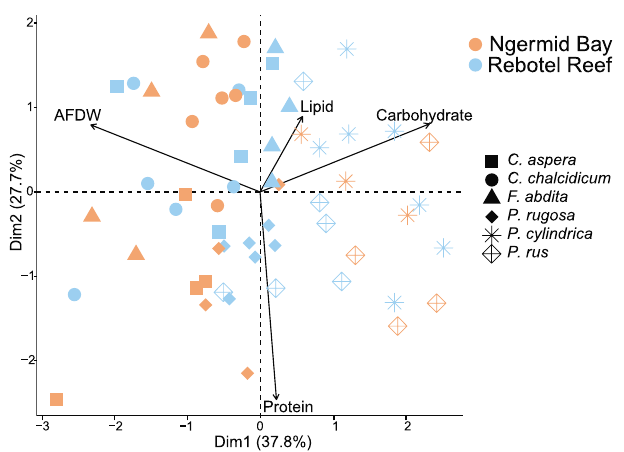
Figure 4. Principal component analysis (PCA) plot of physiological traits for Coelastrea aspera (square), Cyphastrea chalcidicum (circle), Favites abdita (triangle), Pachyseries rugosa (solid diamond), Porites cylindrica (six-pointed asterisk), and Porites rus (open diamond with plus sign) from nearshore (Ngermid Bay; orange) and offshore (Rebotel Reef; blue). Vectors represent direction and comparative strength of four physiological trait’s contribution to sample distribution, with Dim1 and Dim2 explaining 37.8% and 27.7%, respectively, of sample variance. All corresponding Kruskal–Wallis test and two-way ANOVA results, comparing a variable across site and species, are in Table 1, with post-hoc analyses listed in S1. Multivariate analyses results, comparing the impact of site and species and each variable has on sample distribution in the above PCA, can be found in Tables 3 and 4, respectively.